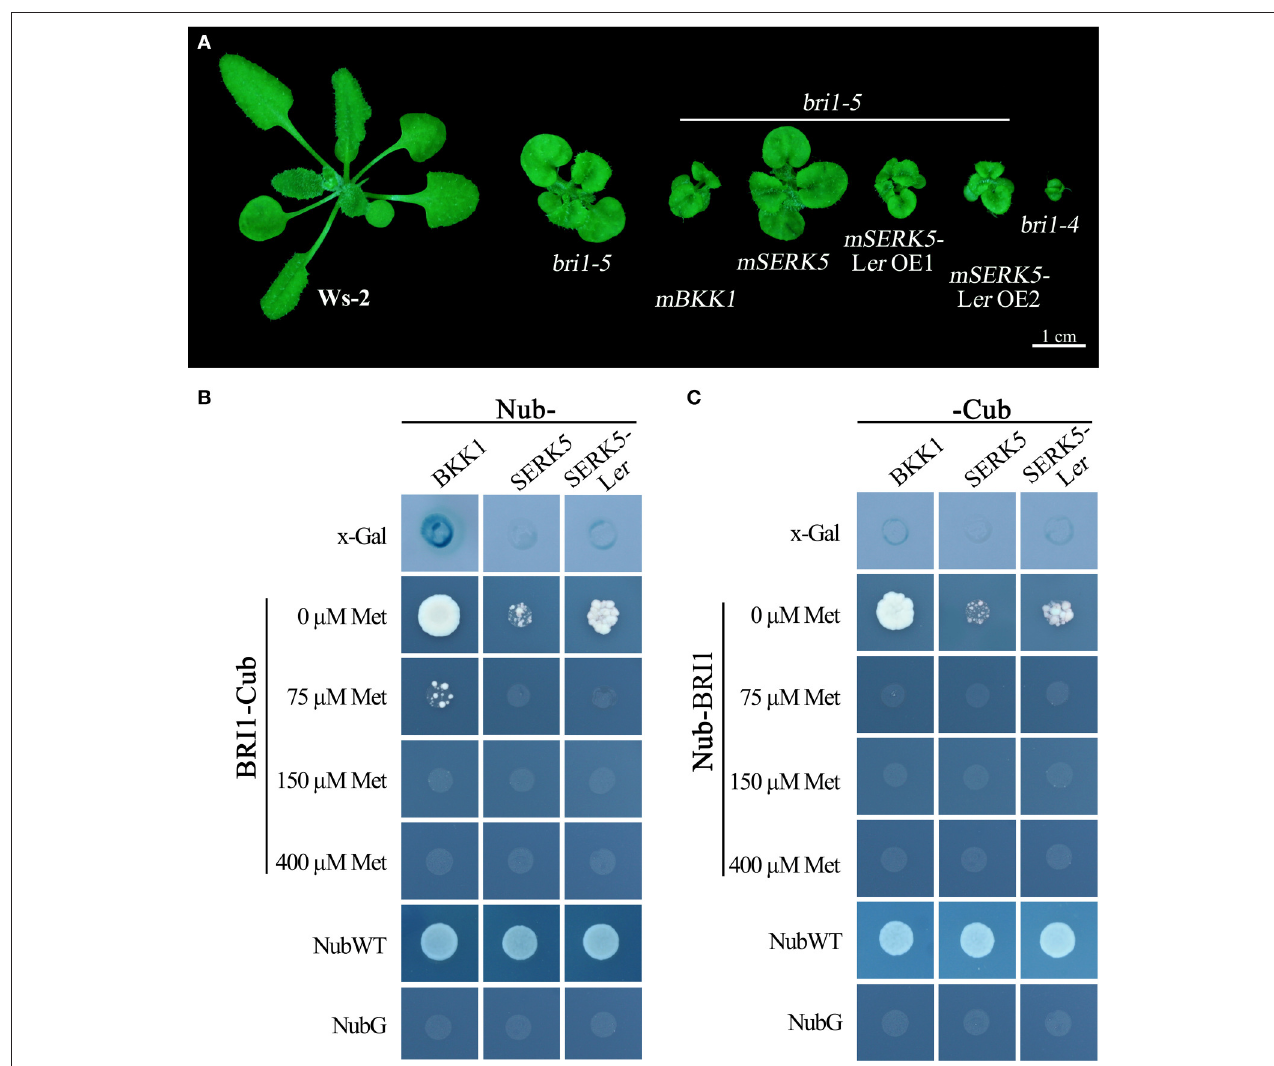
FIGURE 8 | SERK5-L er interacts with BRI1. (A) Overexpression of a kinase-inactive variant of SERK5-L er (K301E) led to a dominant-negative phenotype resembling bri1-4 . Mating-based split ubiquitin system (mbSUS) to show BRI1-SERK5-L er interaction in vivo . Interaction was determined by the growth ability of mated yeast on selective medium (-AHLT) supplemented with 0, 75, 150, and 400 µ M methionine. NubWT and NubG were used as positive and negative control, respectively. (B) BRI1 was cloned as a -Cub fusion, and SERK5 -L er , BKK1, and SERK5 were cloned as a Nub- fusion. (C) BRI1 was cloned as a Nub- fusion, and SERK5 -L er , BKK1, and SERK5 were cloned as a -Cub